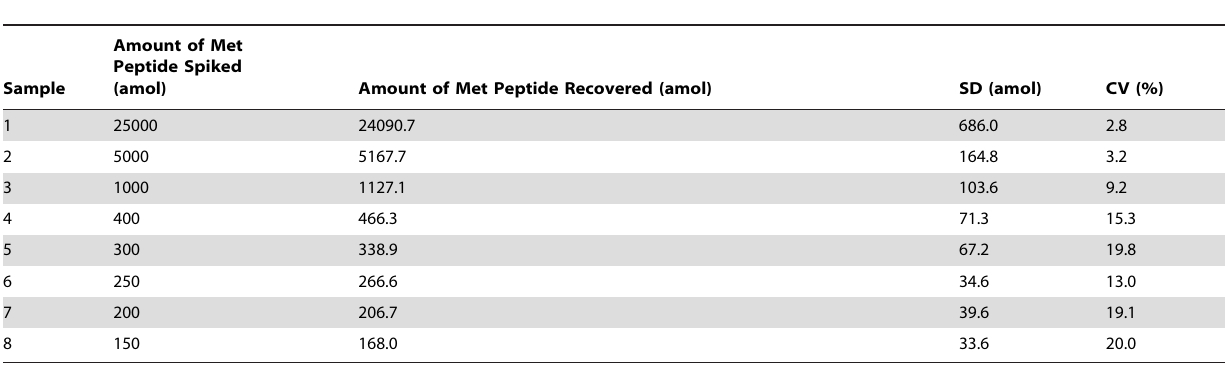
Table 1. Characteristics of Met light peptide spiked SK-BR-3 lysates used to prepare calibration curve to determine limit of